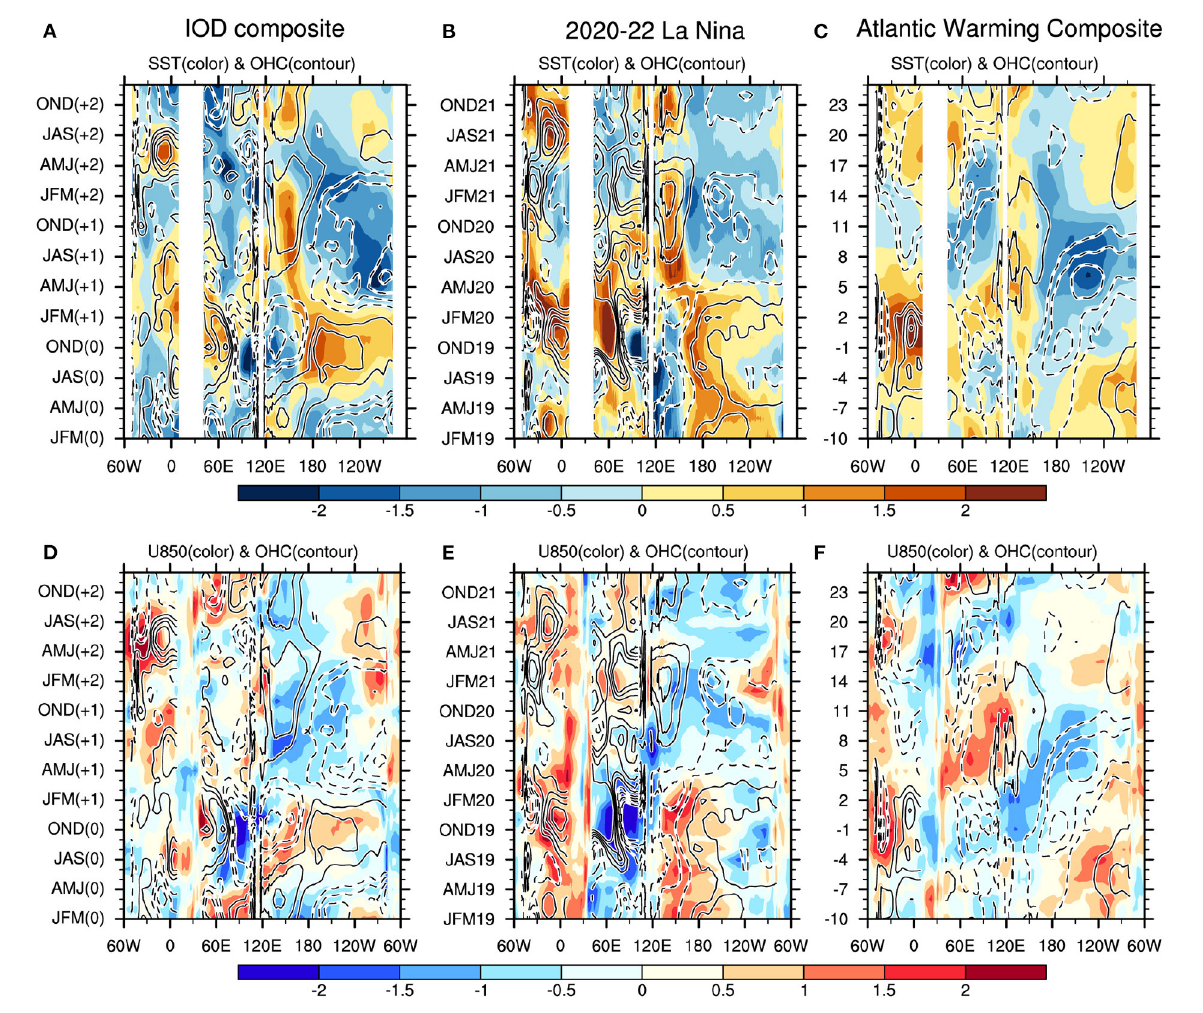
FIGURE5 Hovmöller diagrams of normalized (A–C) SST (colors) and (D–F) zonal wind anomalies at 850 hPa (colors) overlaying with (A–F) OHC (contours) averaged over 2.5 ◦ N–2.5 ◦ S latitude band in (A,D) the IOD composite, (B,E) 2020–2022 La Niña case, and (C,F) Atlantic warming composite. The contour interval is 0.3. Positive and negative counters are solid and broken black lines respectively. We select the three positive IOD years excluding strong preceding El Niño years for the IOD composite (1994, 2006, and 2012) and four Atlantic warming years with different seasons (July 1984, February 1988, March 1996, and May 1998). The amplitudes in these composites are adjusted to fit the 2020–2022 La Niña